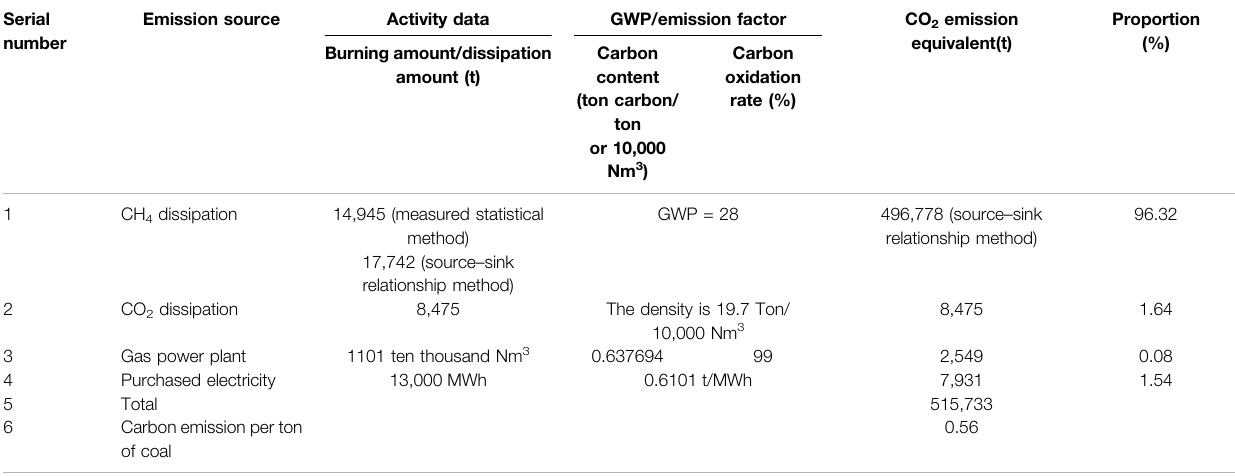
Provided by Zhongheng coal mine. TABLE 7 | Calculation results of CO 2 emission of Zhongheng coal mine.